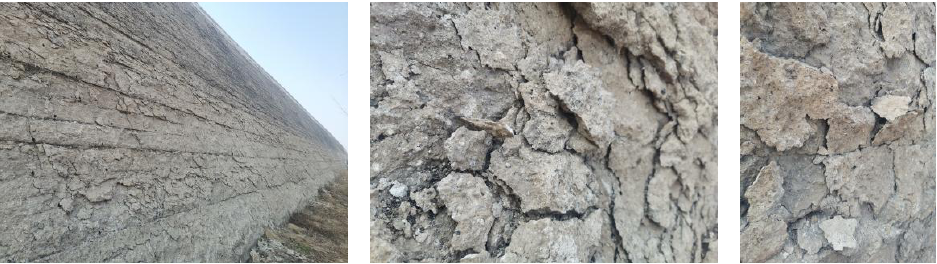
Figure 1. Diseases of the newly repaired earthen city